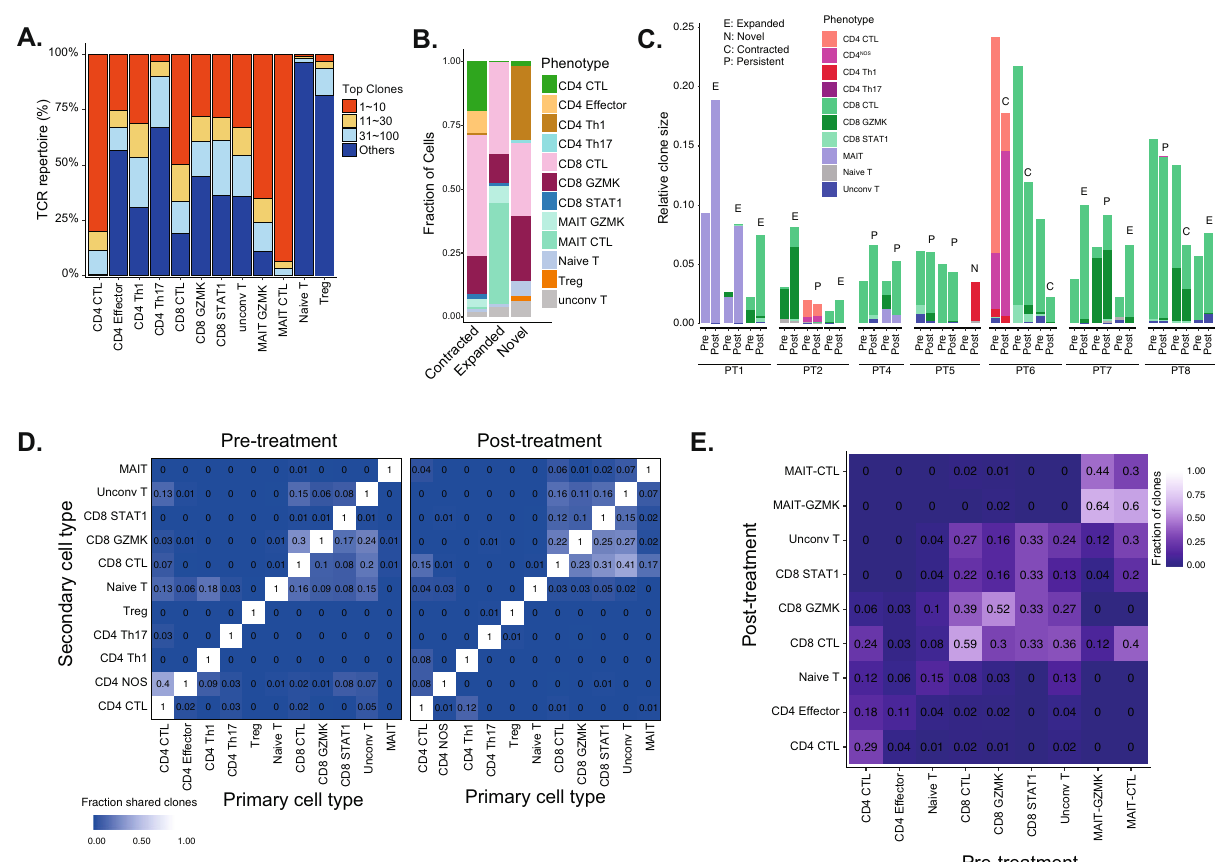
Fig. 5 T-cell clonotype analysis. A Distribution of the TCR clonotype frequency by cell type. B Number of novel, expanded and contracted clonotypes by cell type. C Fraction of T cells from top, most abundant 3 clonotypes. D Heatmap of overlapping clonotypes between different cell types at pre- and post- treatment timepoints. E Heatmap for observed phenotype transitions for matched clones at pre- and post- treatment